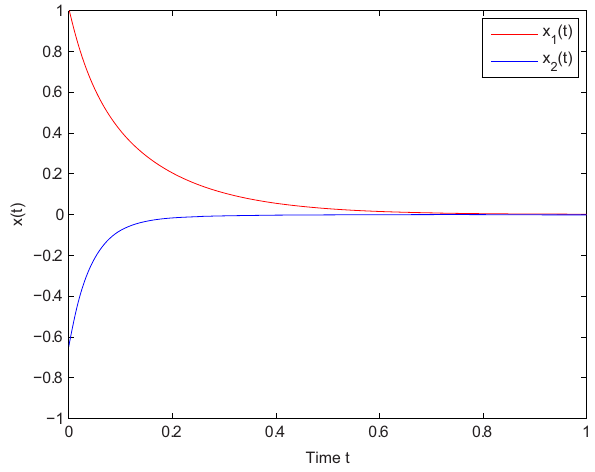
Figure 1: Asymptotic behavior in almost sure sense of the solution for equation ( 4.3